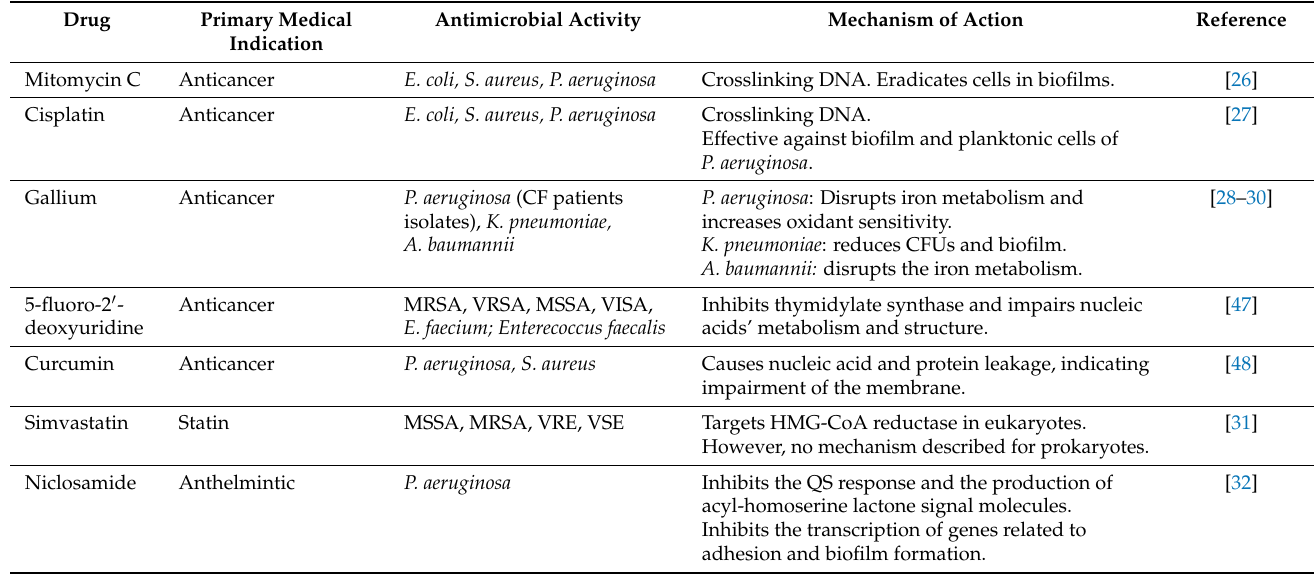
Table 1. “Nonantibiotic” approved drugs with antimicrobial activity towards MDR